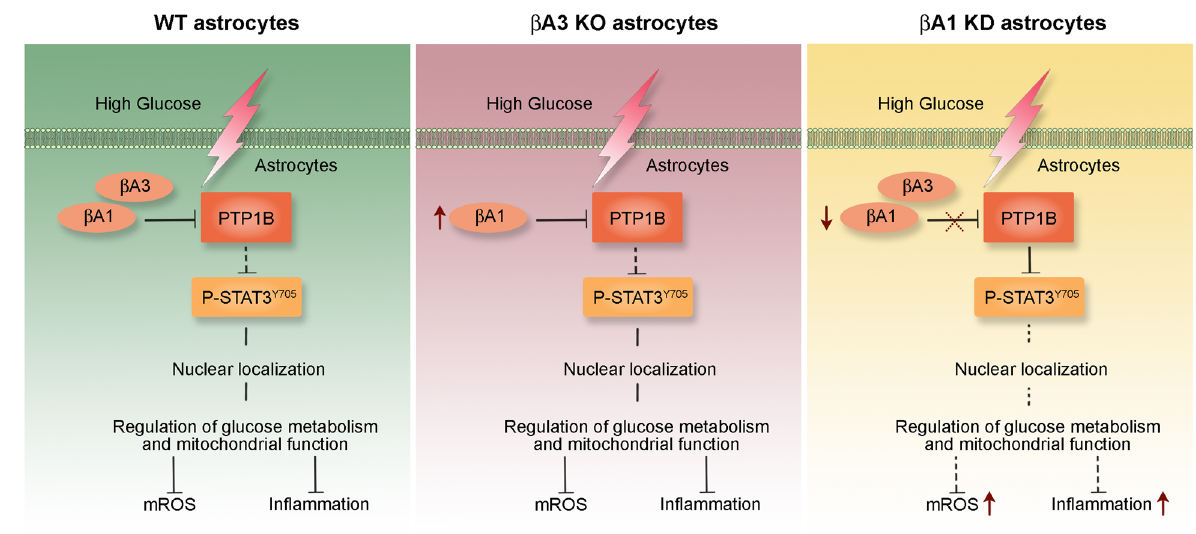
Fig. 10 β A1-crystallin regulates PTP1B/STAT3 signaling axis in retinal astrocytes. High glucose exposure to WT and β A3 KO astrocytes produce no deleterious effect due to the appropriate regulation of PTP1B-dependent STAT3 signaling and glucose metabolism by the presence of β A1-crystallin in these cells. However, knockdown of β A1-crystallin, triggers abnormally high PTP1B activity, thereby inhibiting the downstream STAT3 signaling and glucose metabolism, causing oxidative stress and in fl ammation in β A1 KD cells. These changes in astrocytes might trigger DR-like pathology in the β A1 KD mice in diabetic conditions. Taken together, and to the best of our knowledge, this study provides evidence that supports the role of β A1-crystallin in maintaining retinal homeostasis in hyperglycemic stress and offers a possible target for the treatment of